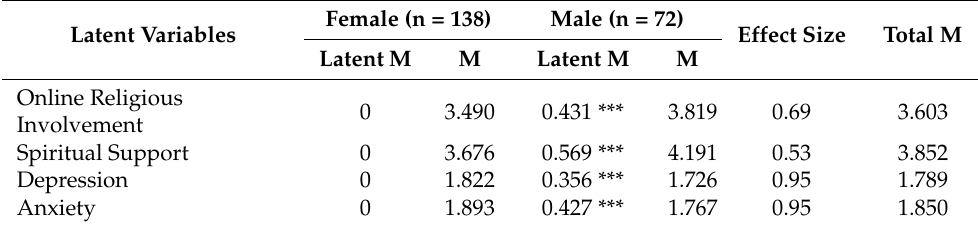
Table 3. Results of latent mean